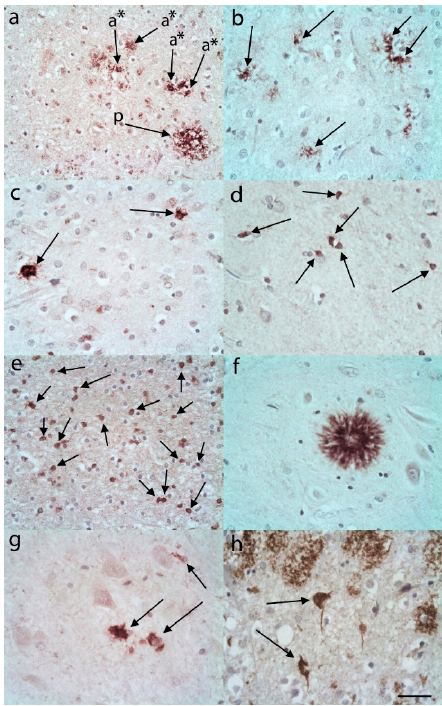
Figure 2. C3 immunohistochemistry in Alzheimer’s disease cases. ( a ) In the upper frontal cortex plaques (p,arrows) and numerous ASLCs (a*,arrows) were labelled. ( b ) There were also numerous ASLCS not adjacent to plaques in the upper frontal cortex (arrows). ( c ) These C3 immunopositive ASLCs were also evident in the upper temporal cortex (arrows). ( d ) The lower frontal cortex revealed moderate to large numbers of C3 immunopositive ASLCs (arrows) and they were numerous in the frontal white matter ( e , arrows). ( f ) Well formed C3 immunopositive plaques were evident in the CA4 region of the hippocampus. There were also a number of C3 immunopositive ASLCs in the CA4 region ( g , arrows). ( h ) C3 immunohistochemistry labelled occasional neurofibrillary tangles (arrows). Anti-C3d. Original magnifications ( a ), ( d ), ( e ), ( f ) ×40 (NA 0.9), ( b ), ( c ), ( g ), ( h ), ×60 (NA 0.9 ). Scale Bar ( a ) − 100 µm, ( b ) − 60 µm, ( c ), ( d ), ( f ), ( h ) − 50 µm, ( e ) − 40 µm, ( g ) − 30 µm.